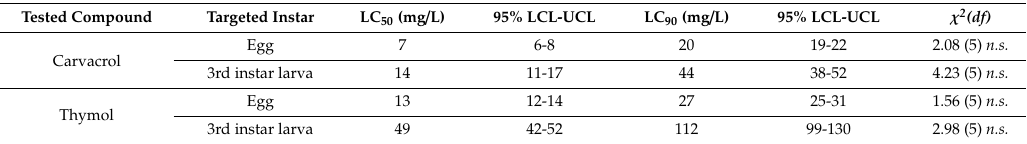
Figure 1. Insecticidal activity of the selected monoterpenoids carvacrol and thymol at di ff erent concentrations against eggs ( a ) and 3rd instar larvae ( b ) of Culex pipiens mosquitoes after 24 h. T-bars indicate standard errors; above each column, di ff erent letters indicate significant di ff erences among means (ANOVA, Tukey’s HSD test, p < 0.05). Table 1. Probit analysis showing the toxicity of carvacrol and thymol against eggs and 3rd instar larvae of the West Nile vector Culex pipiens